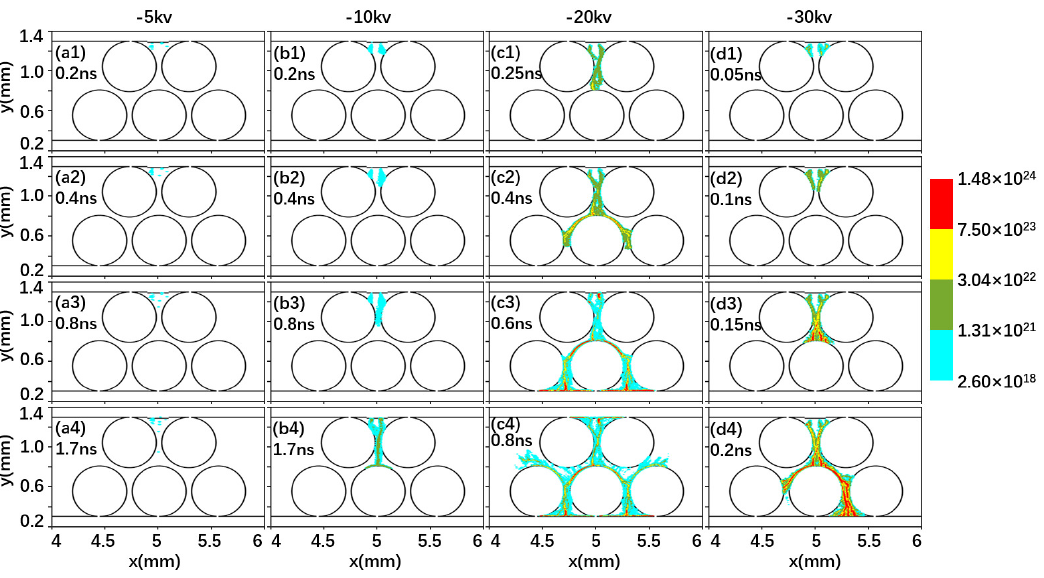
Figure 2. N + ion density (m − 3 ) for the same conditions as in Figure 1. 2